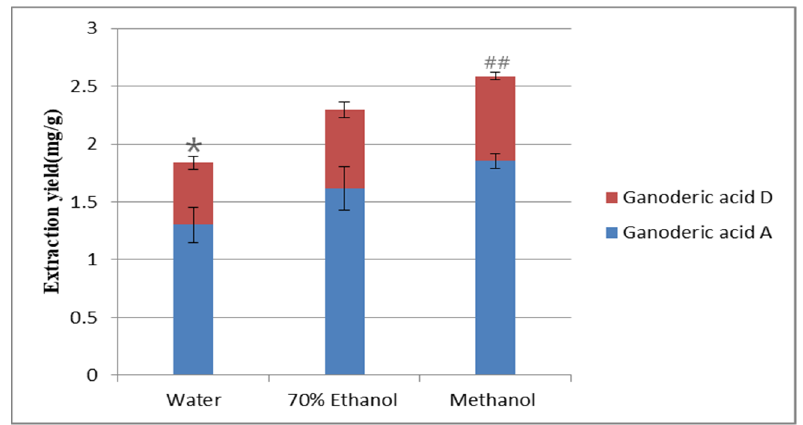
Figure 1. Influence of different extraction solvents. Compared with methanol group: * p < 0.05. Compared with [HMIM] Br/methanol group: ## p < 0.01.